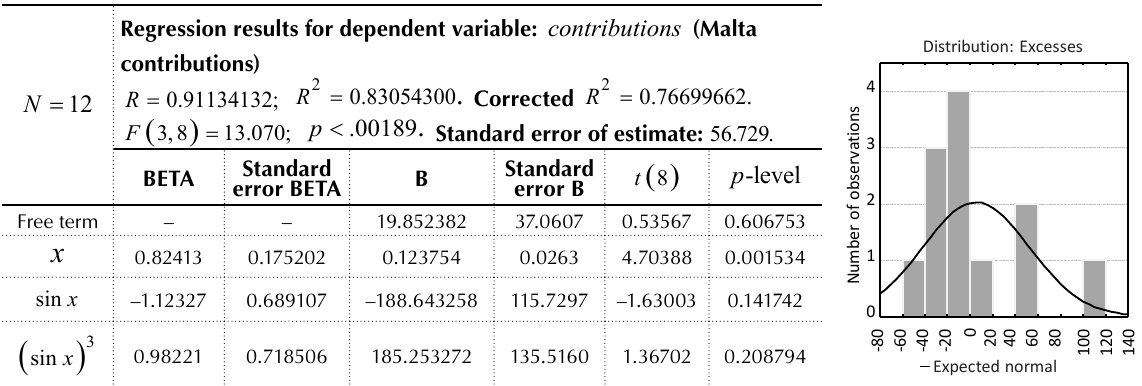
Table 7b. The results of regression for contributions of the members of the Investor Compensation ( ) c Scheme (Malta) from its volume ( ) x